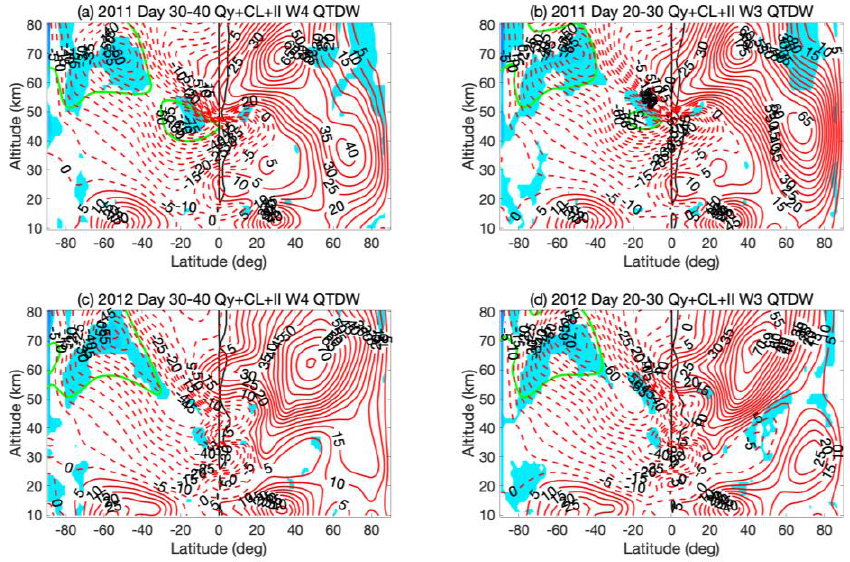
Figure 8. Diagnostic analysis results for MERRA − 2 background conditions on ( a , c ) days 30 − 40 and ( b , d ) days 20 − 30 during ( a , b ) 2011 and ( c , d ) 2012. The red contours show the mean zonal wind (solid lines for eastward winds and dashed lines for westward winds). The blue − shaded regions denote the baroclinic/barotropic instability (Qy) and the black solid lines enclose the regions with inertial instability (II). The green solid lines represent the critical layers (CL) for QTDW.